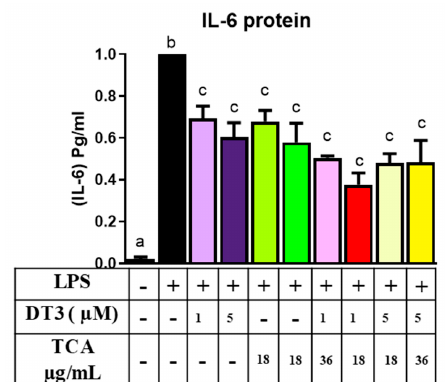
Figure 5. Delta-tocotrienol and TCA decreased IL-6 secretion: All doses of DT3 and TCA significantly reduced IL-6 secretion measured in 3T3-L1 adipocytes compared to LPS control Means with different letters (a, b, c) are significant. n = 5, p < 0.05.